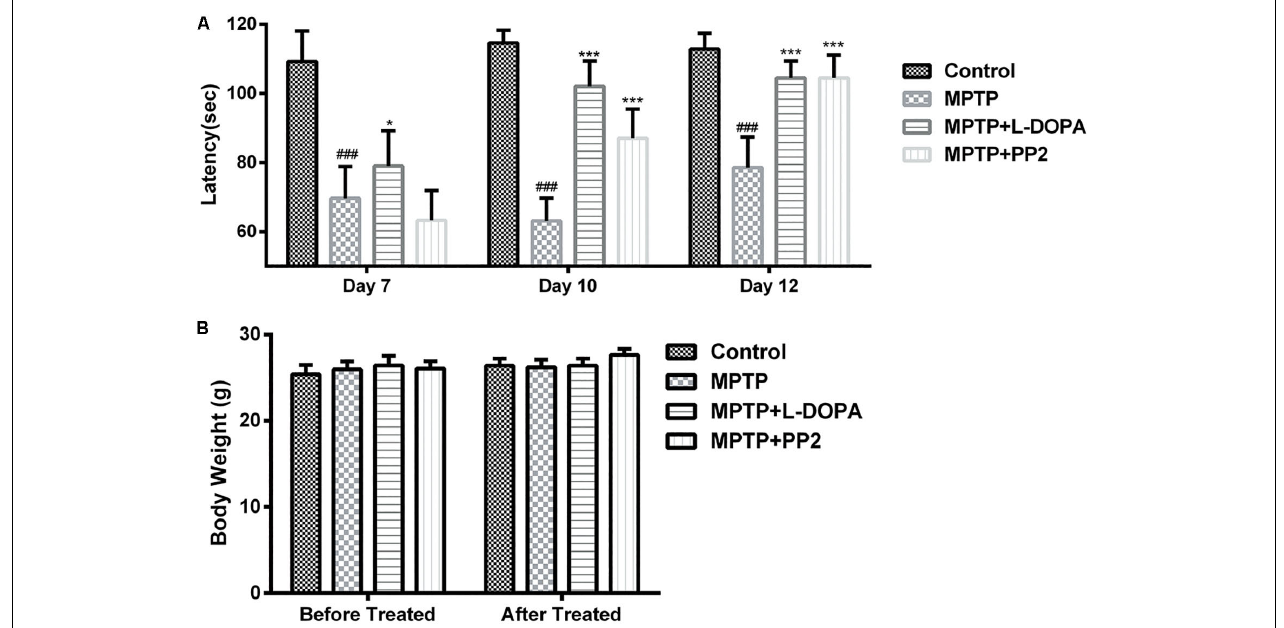
FIGURE 7 | Src inhibition improved the motor behavior of the 1-methyl-4-phenyl-1,2,3,6-tetrahydropyridine (MPTP)-treated mice. Evaluation of mice motor performance using the rotarod test. (A) Latency represent time of mice staying on the rod on days 7, 10, and 12. (B) Body weight was measured before and after the experiment (at days 1 and 13). Each bar represents the mean ± SEM. ### P < 0.001 vs. control group, * P < 0.05 and *** P < 0.001 vs. MPTP group.